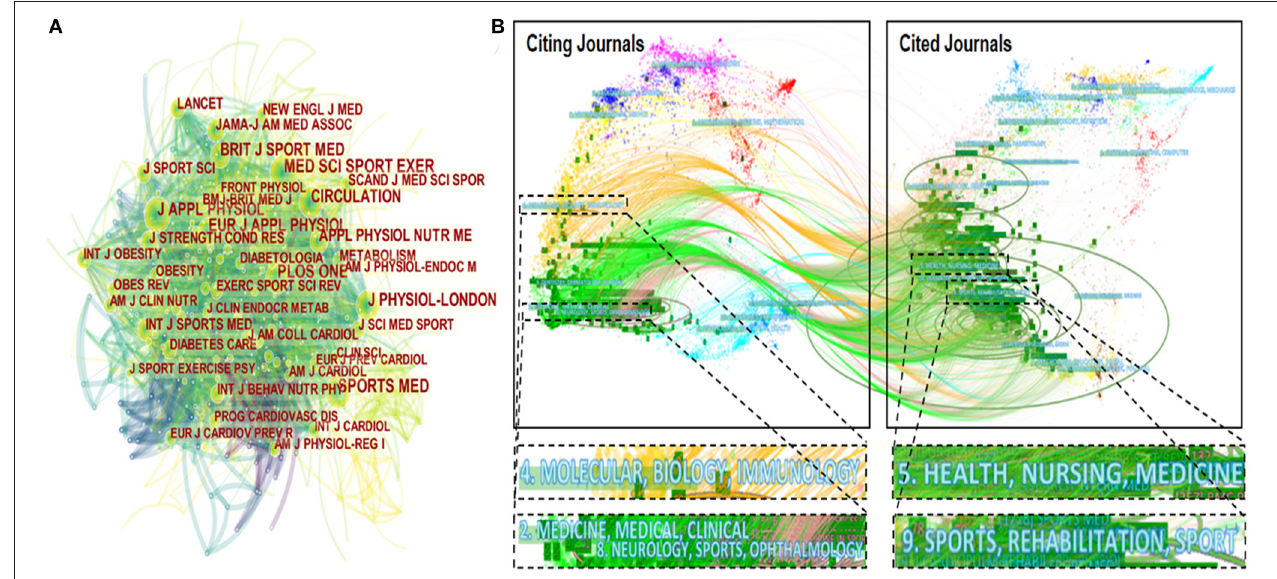
FIGURE 4 | The map of co-cited journals (A) ; a dual-map overlay of journals that published literature in the HIIT-HP field (B) .